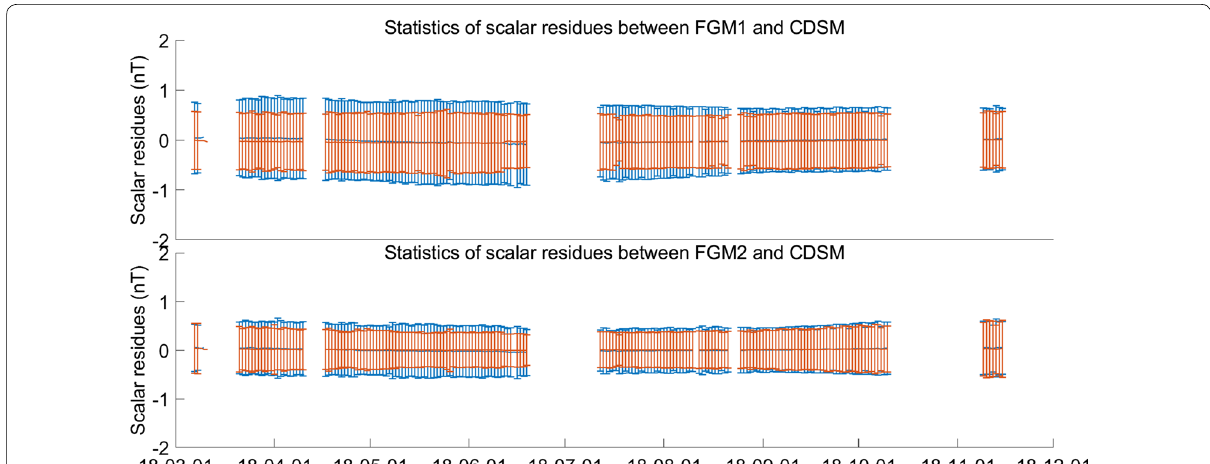
Fig. 12 Scalar residues between FGM1, FGM2, and CDSM. Red dayside residue, Blue nightside residue. The difference between the field magnitude calculated from the calibrated FGM components and the magnitude directly measured by CDSM is about 0.5 nT (1 σ ) which is stable over time